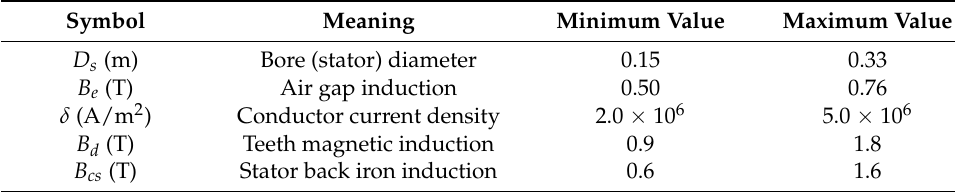
Table 1. Design parameters in the brushless DC motor benchmark.